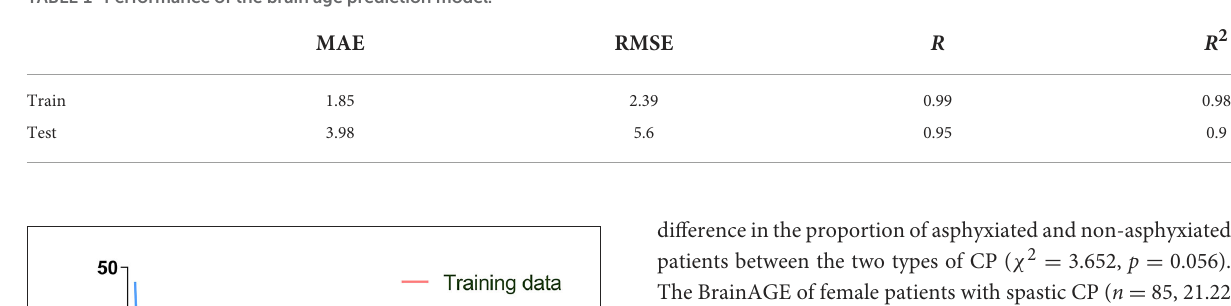
TABLE 1 Performance of the brain age prediction model.